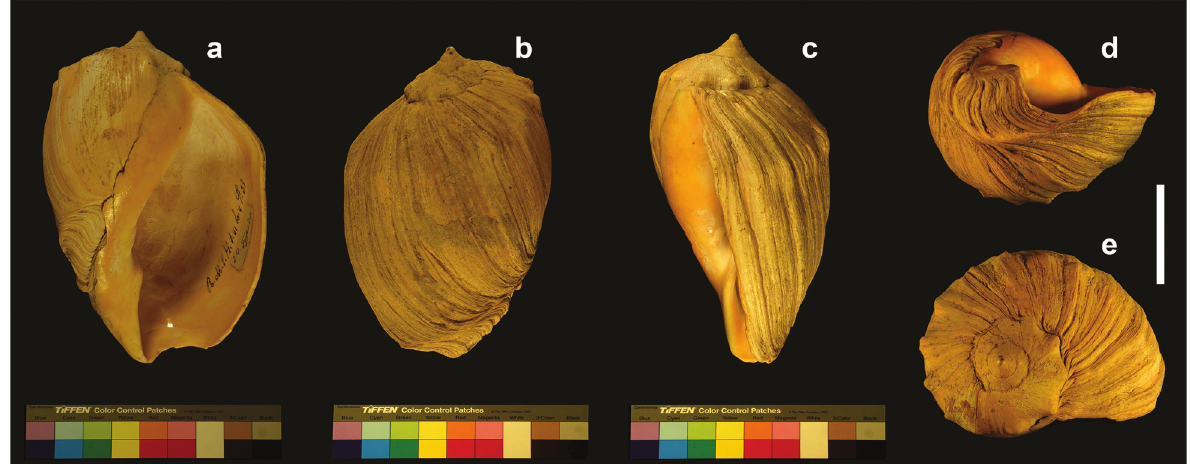
Figure 27. Voluta colocynthis typica , specimen figured by Lahille (1895: pl. V, fig. 38) a Apertural view b Dorsal view c Lateral view d Umbilical view e Apical view. Scale bar: 5